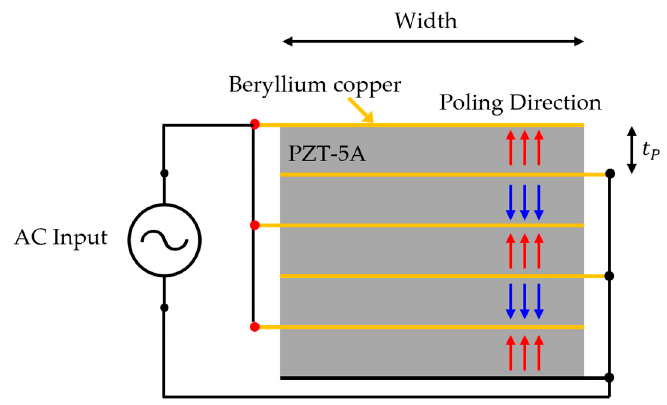
Figure 5. Schematic of stacked piezoelectric transducer.